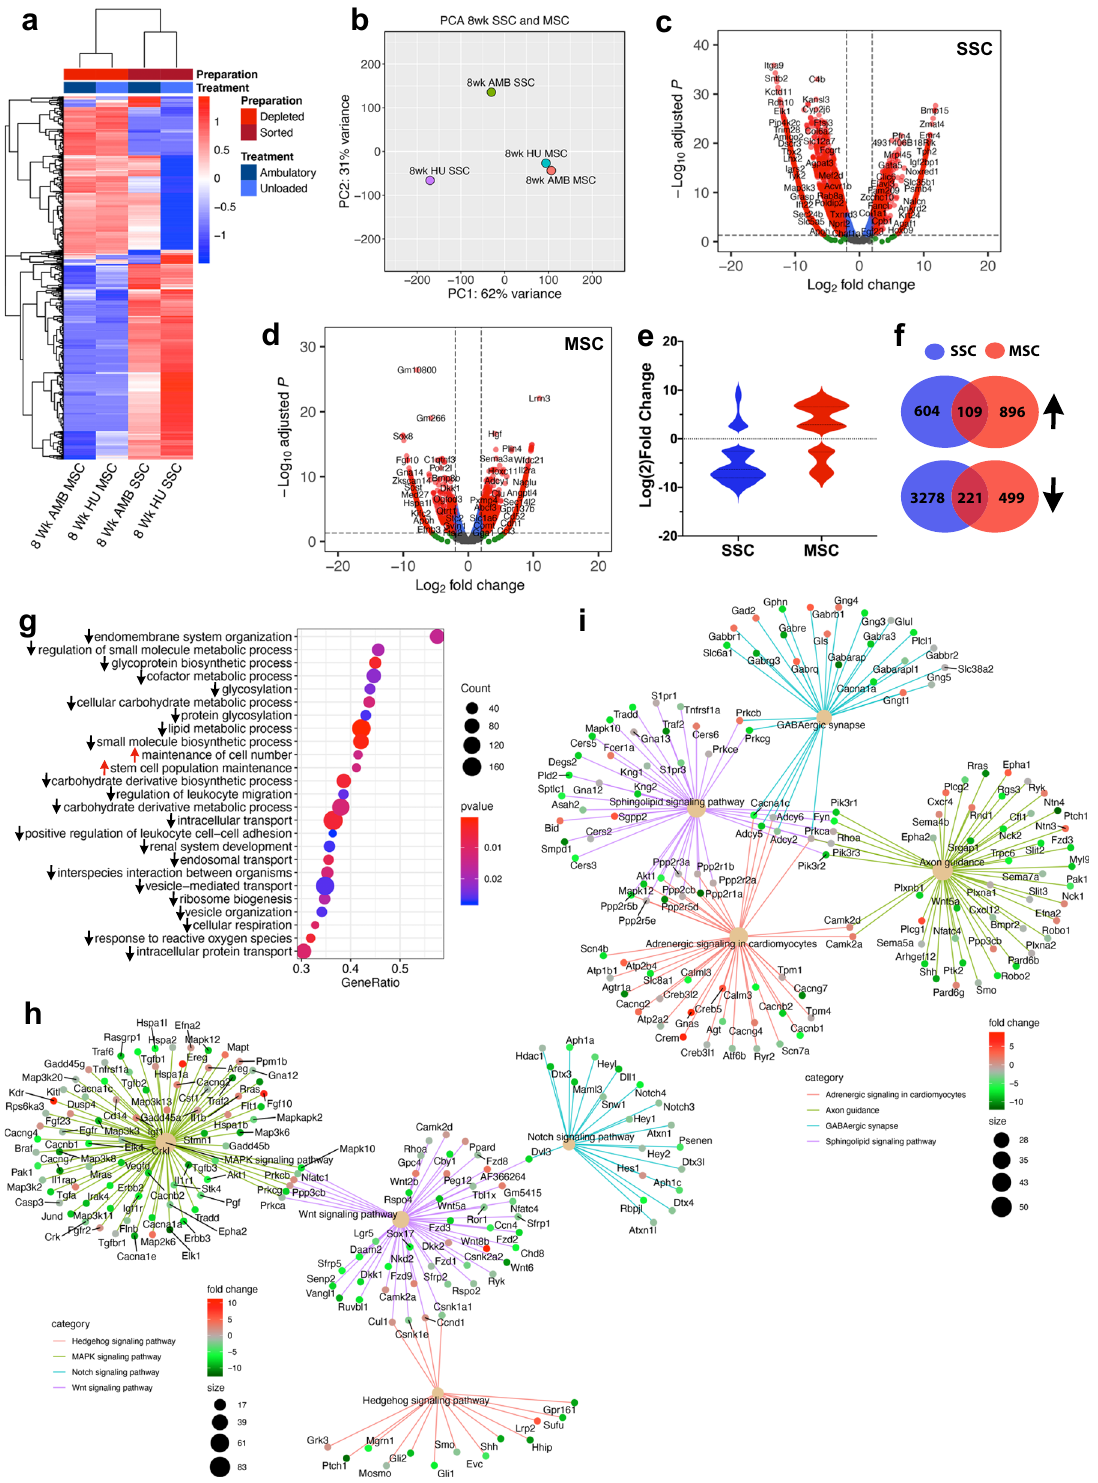
Fig. 3 Transcriptional pro fi ling reveals disparate impacts of 8wk HU on SSCs and MSCs. a Heat map of the top 1000 DEGs in SSCs and MSCs from 8wk HU vs. AMB mice as determined by RNA-seq analysis. Colors correspond to per-gene z -score computed across each row. b PCA analysis of data from a . c , d Volcano plots showing Log2 fold-change (FC) values for DEGs and their corresponding p -values in SSCs and MSCs from 8wk HU vs. AMB mice. Red circles denote DEGs with Log2 FC > 2. e Violin plot of data from ( c , d ) showing number of DEGs up or downregulated by >Log2 fold in SSCs or MSCs in response to HU. f Venn diagram showing overlap of upregulated (109/1718, 6%) and downregulated (211/3777, 15.5%) DEGs common to SSCs and MSCs. g Top GO terms based on p-value identi fi ed by GSEA of DEGs in SSCs from 8wk HU vs. AMB mice. Red arrows indicate upregulated and black arrows indicate downregulated gene sets corresponding to each GO term. h , i KEGG pathway analysis showing fold-change of DEGs within gene regulatory networks related to environmental information processing ( h ) and organismal systems ( i